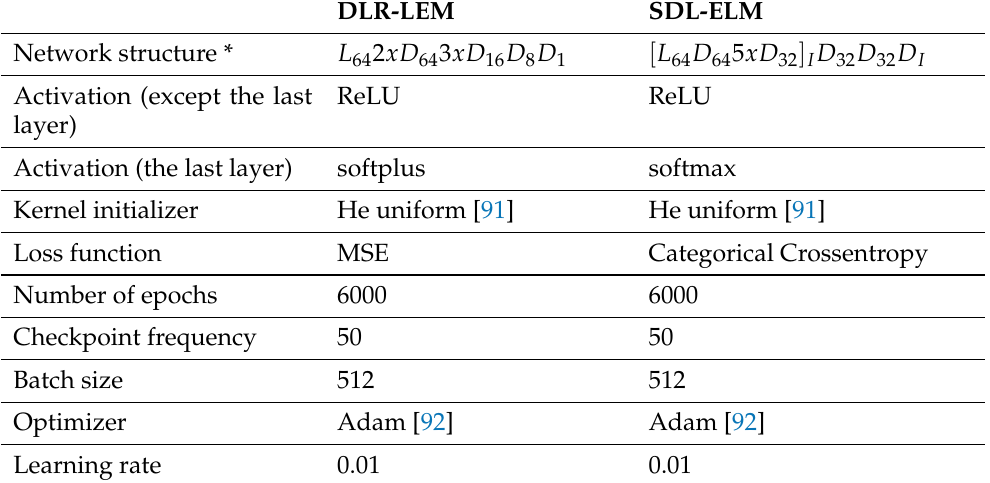
Table 1. Neural network structure and training